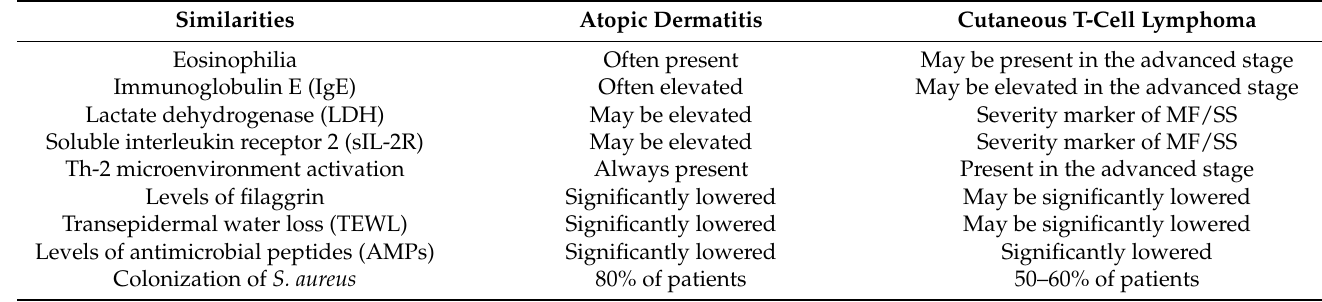
Table 1. Clinical and immunological similarities between atopic dermatitis (AD) and cutaneous T-cell lymphoma (CTCL). Similarities Atopic Dermatitis Cutaneous T-Cell Lymphoma Eosinophilia Often present May be present in the advanced stage Immunoglobulin E (IgE) Often elevated May be elevated in the advanced stage Lactate dehydrogenase (LDH) May be elevated Severity marker of MF/SS Soluble interleukin receptor 2 (sIL-2R) May be elevated Severity marker of MF/SS Th-2 microenvironment activation Always present Present in the advanced stage Levels of filaggrin Significantly lowered Transepidermal water loss (TEWL) Significantly lowered Levels of antimicrobial peptides (AMPs) Significantly lowered Significantly lowered Colonization of S.